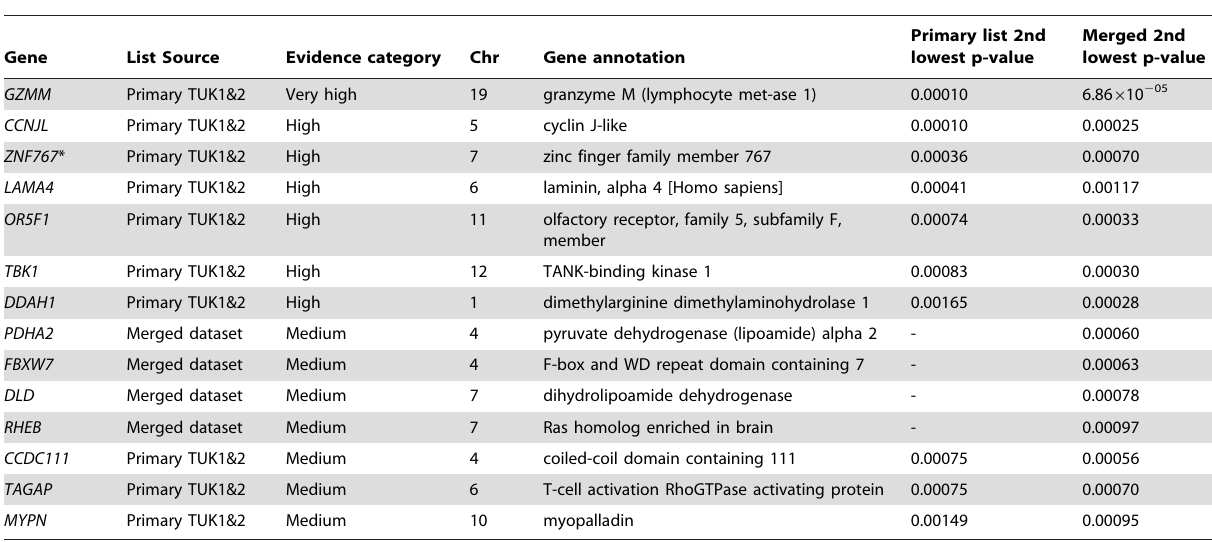
Table 3. Genes associated with heat pain sensitivity using six methods of gene-centric variant burden